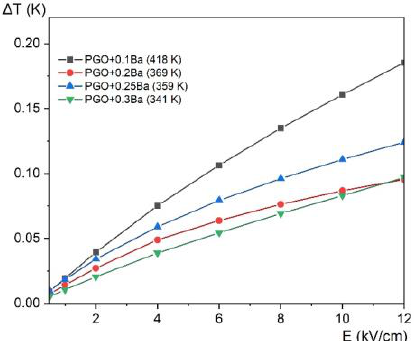
Figure 12. Electrocaloric temperature change ( ∆ T ) as a function of the electric field at the maximum ∆ T temperature (given in the parenthesis in the legend) for PGO + 0.1Ba, 0.2Ba, 0.25Ba, and 0.3Ba.